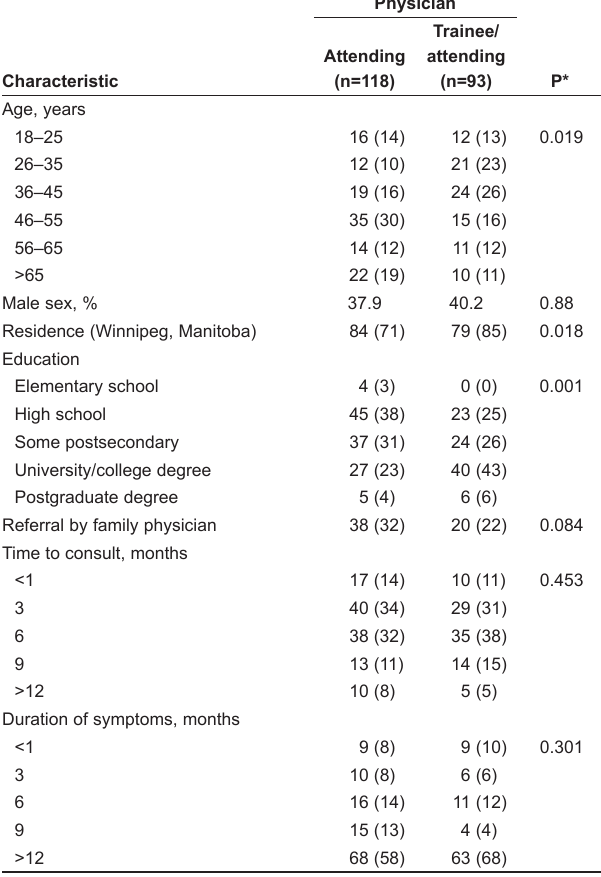
TAble 1 baseline demographics and patient